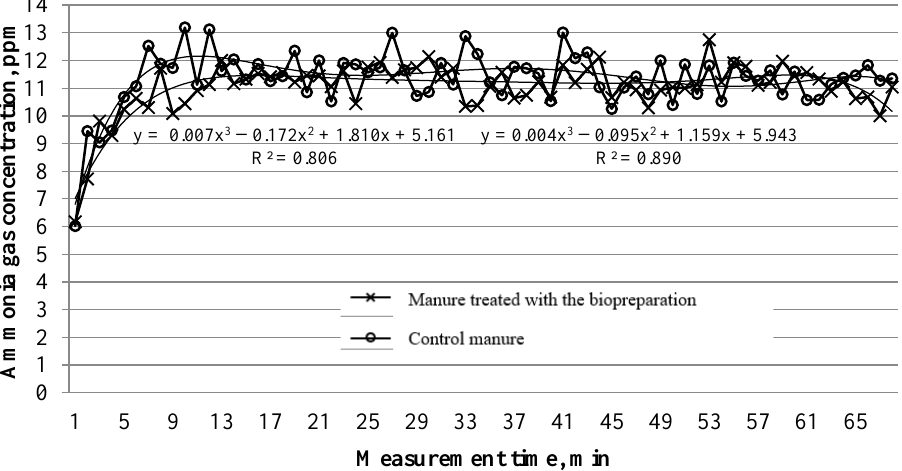
Figure 5. Change in ammonia concentration in the wind tunnel with the addition of the manure treated with the biopreparation and the control manure without additives (55 days after the addition of the biopreparation, the manure is mixed).